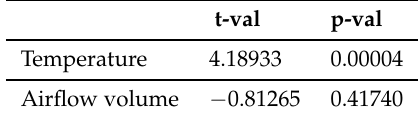
Table 3. Test between pretraind model and non-pretrained